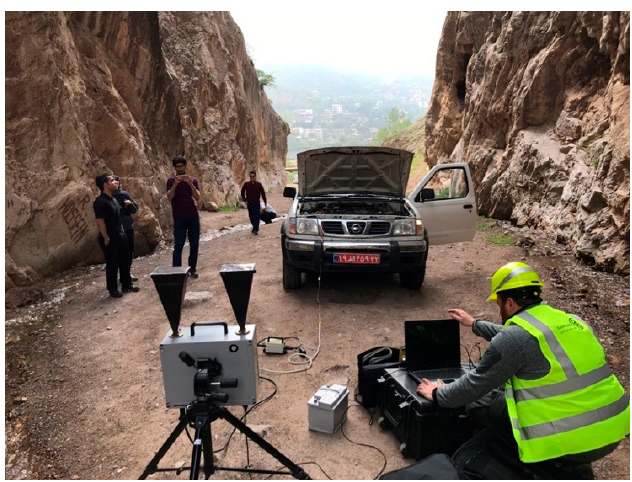
Figure 3. Radar deployment under the Veresk Bridge.